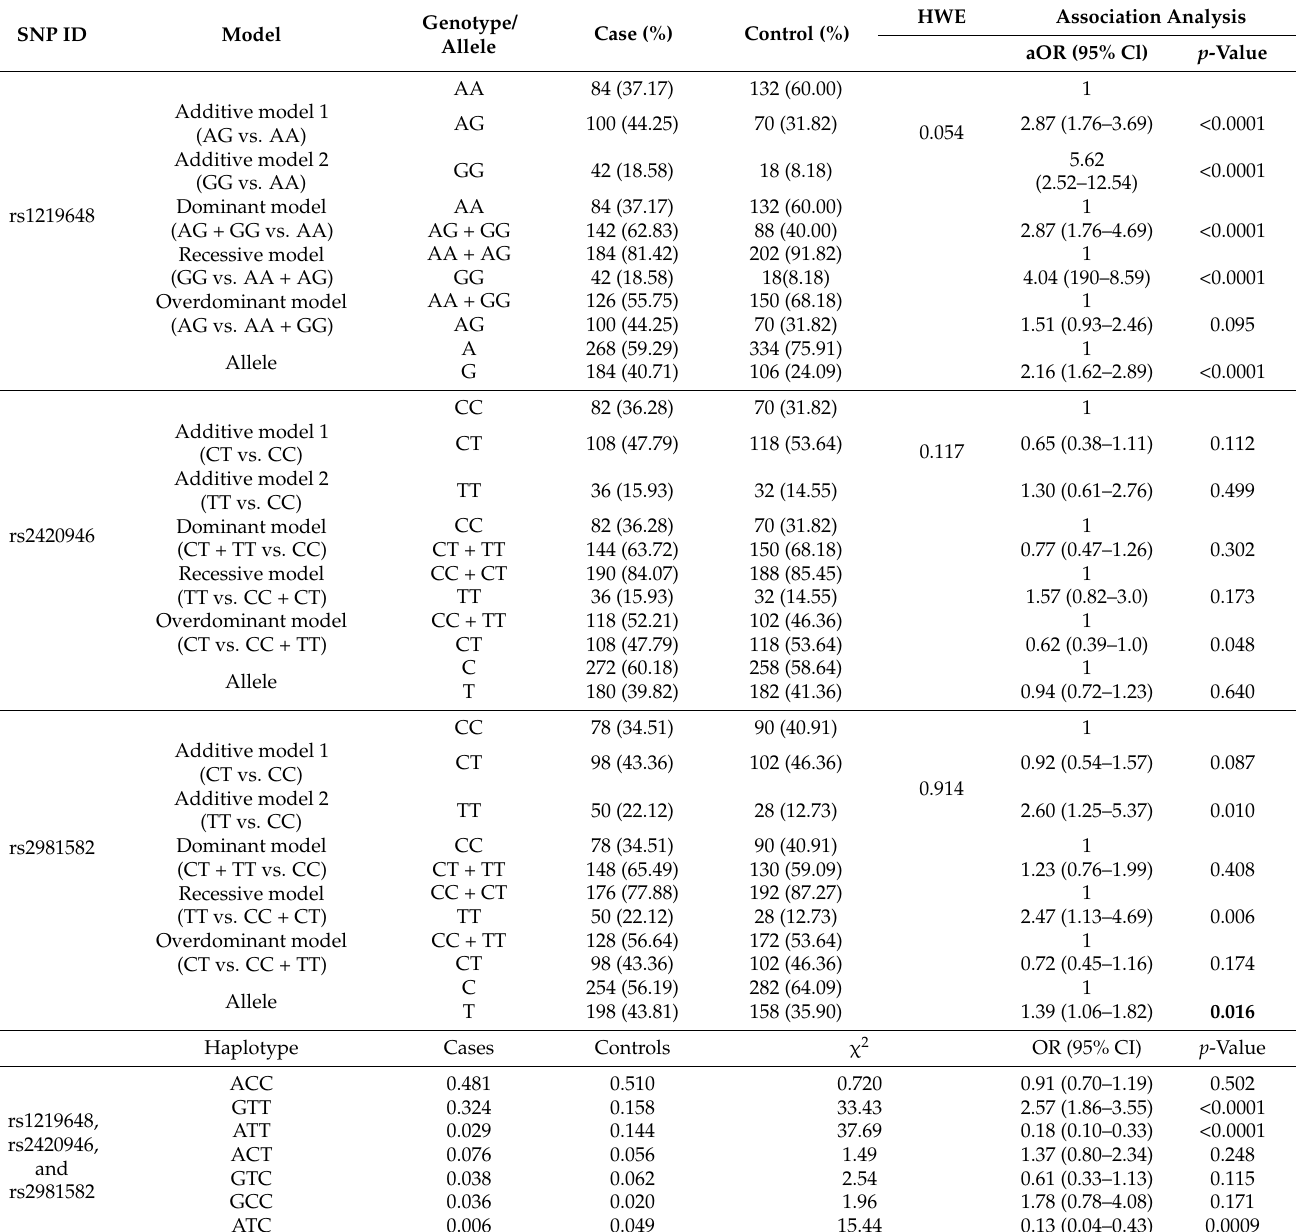
Table 3. Genotype frequencies and association analysis of FGFR2 rs1219648, rs2420946, and rs2981582 polymorphisms with breast